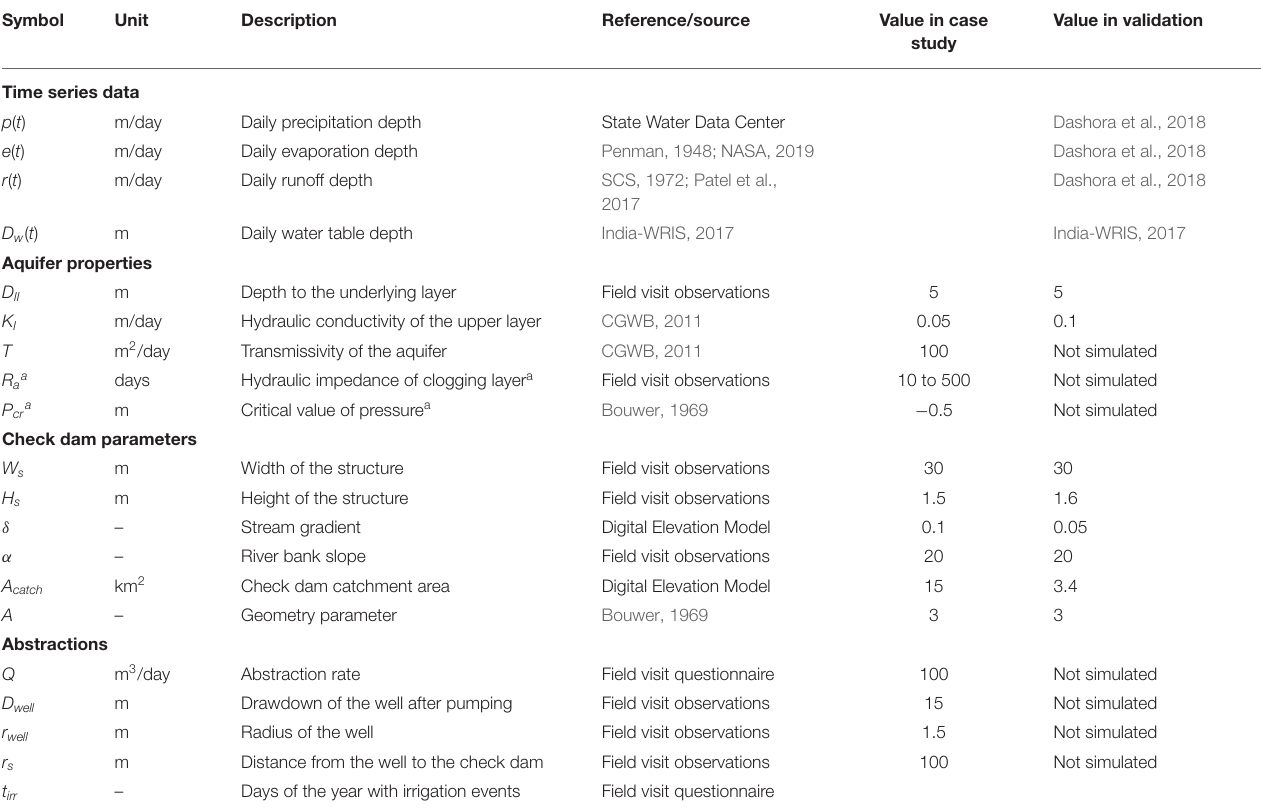
TABLE 1 | Input data for the model and values used in the case study and validation.